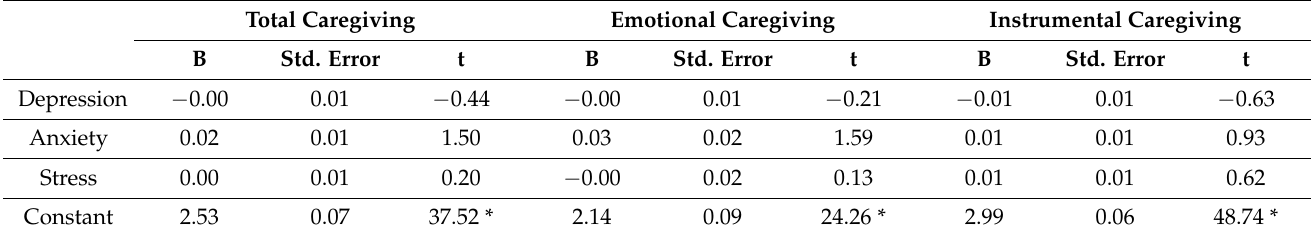
Table 3. Maternal caregiving capacity and relatively variable